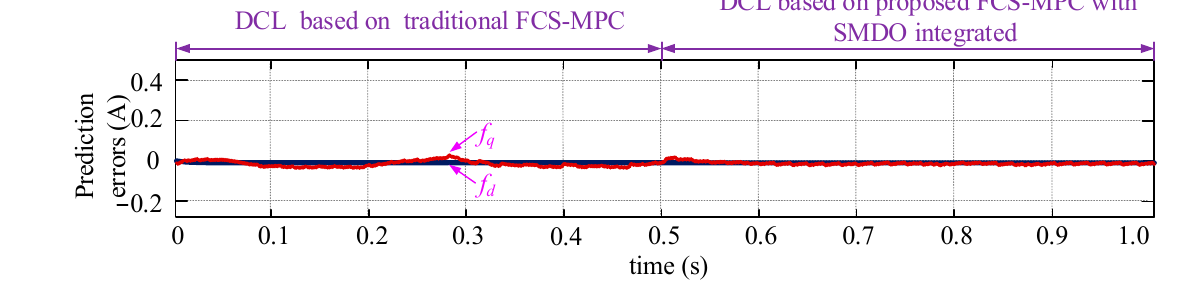
Figure 15. Comparative results of the current prediction errors before and after the proposed SMDO-based MPC method are employed ( L f_mea = 4 L f , L l_mea = 3 L l , R f_mea = 0.5 R f , R l_mea = 0.3 R l ).